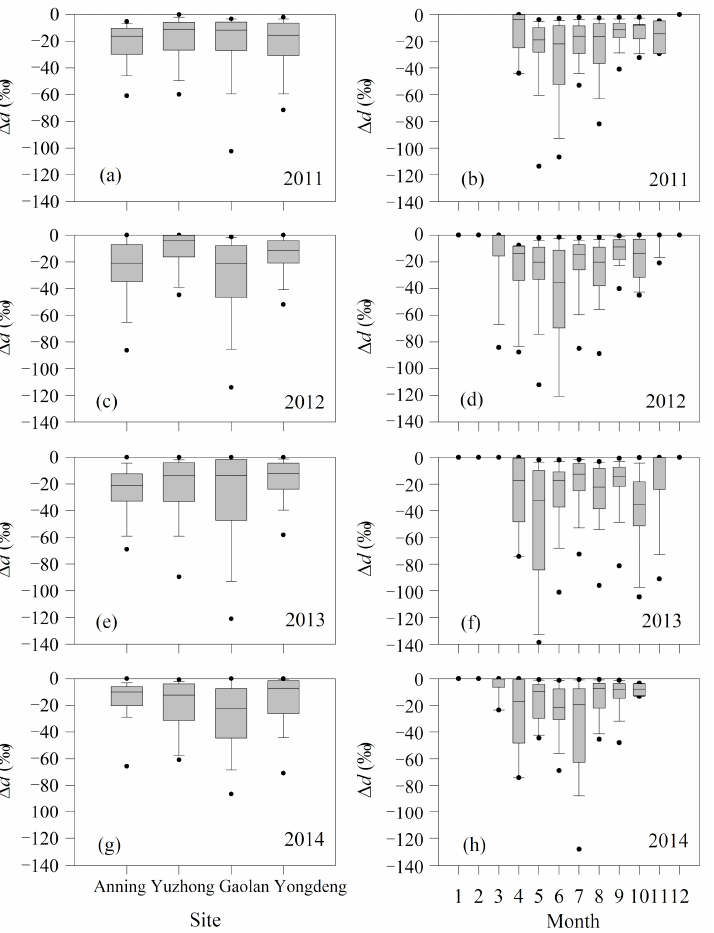
Figure 7. Regional ( a , c , e , g ) and monthly ( b , d , f , h ) variations of ∆ d in 2011 ( a , b ), 2012 ( c , d ), 2013 ( e , f ) and 2014 ( g , h ).